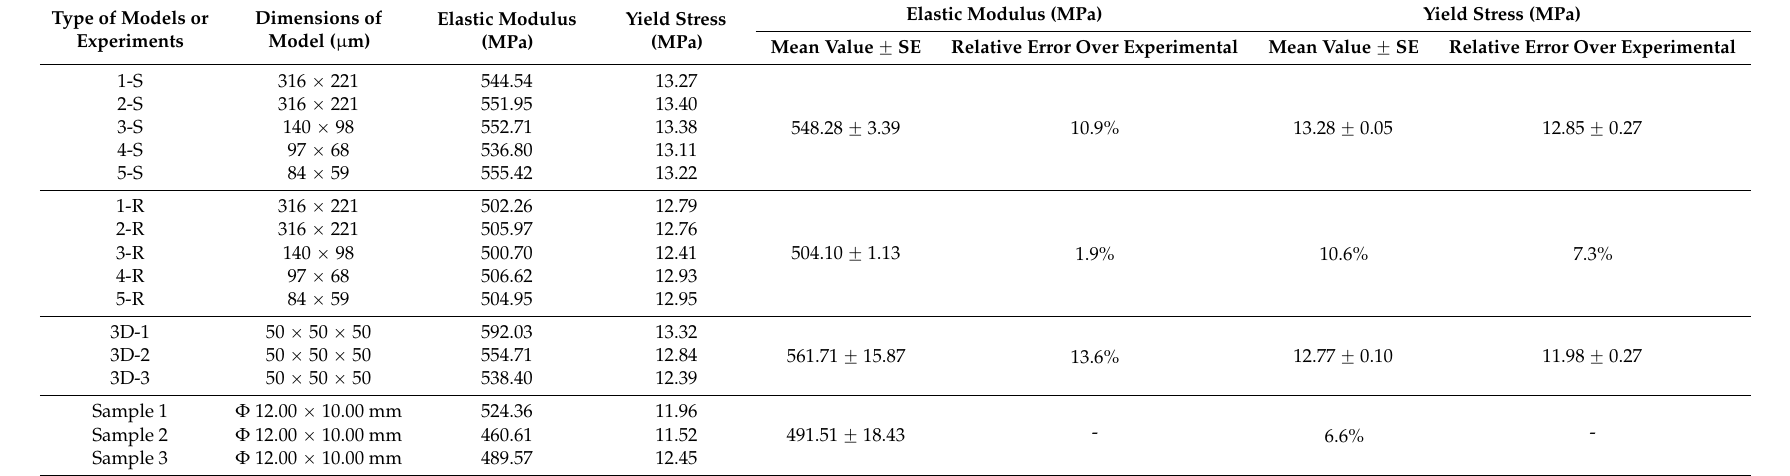
Table 3. Comparison of elastic modulus and yield stress between simulations and experiments. SE represents standard